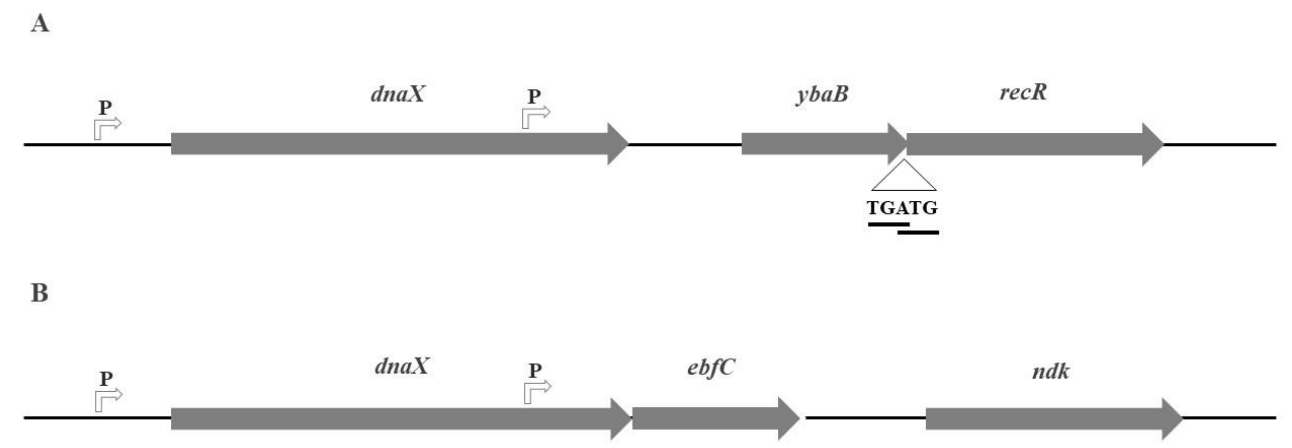
Figure 1. Operon structure of dnaX - ybaB-recR in Escherichia coli and that of dnaX-ebfC in Borrelia burgdorferi . ( A ) Operon structure of dnaX-ybaB-recR observed in E. coli . The initiation codon of ybaB and the termination codon of recR show overlap. ( B ) dnaX-ebfC operon of B. burgdorferi . The two promoters, one upstream of dnaX and the other located in the dnaX structural gene, are shown. Arrows indicate the promoter (P) and direction of transcription. The schematic structure of the operons is not to scale.